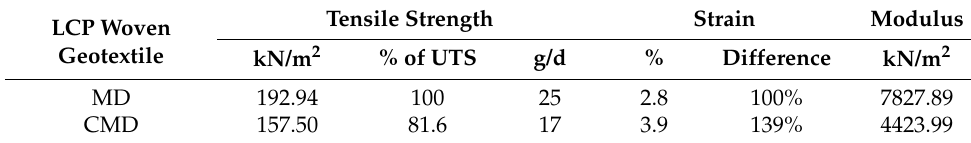
Table 3. Tensile characteristics of LCP woven geotextile in weft and warp directions. LCP